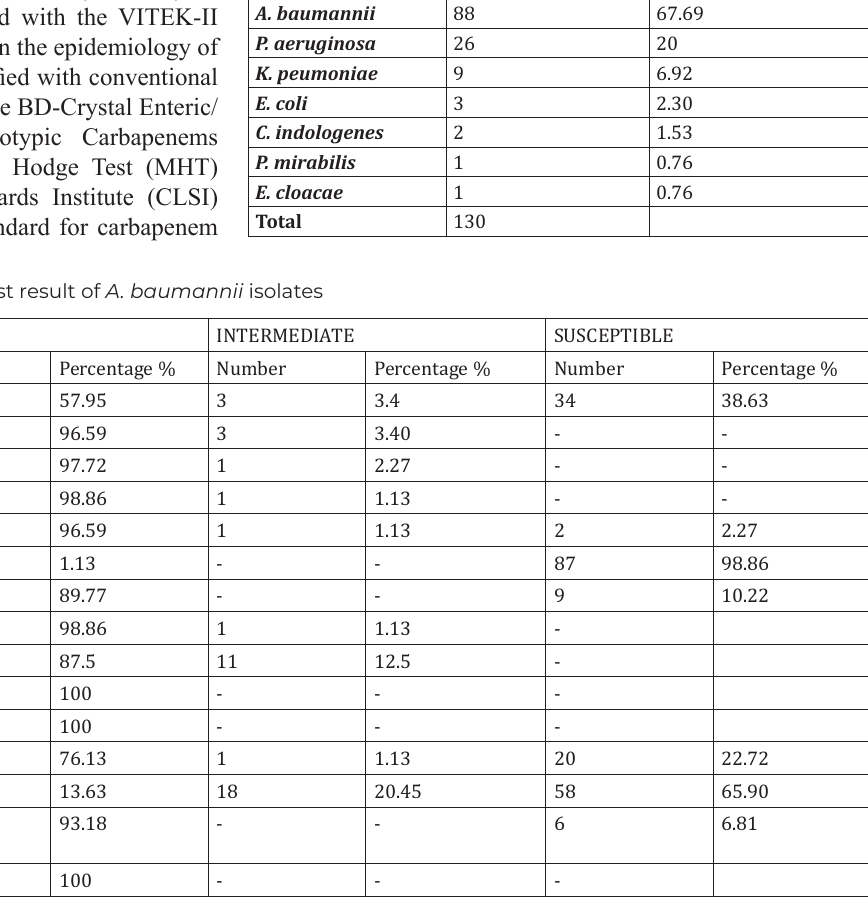
Species distribution of 130 isolates included in the study